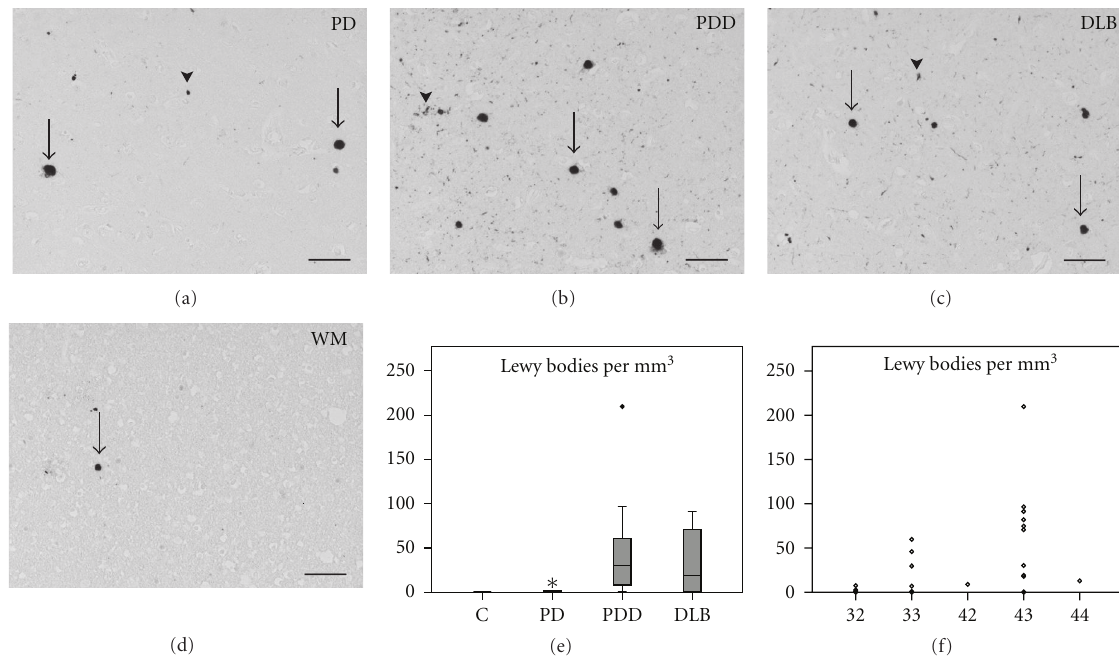
Figure 4: α -synuclein pathology in the human frontal cortex. (a–c) Lewy bodies (arrows) and Lewy neurites (arrowheads) in the grey matter of a Parkinson’s disease (PD; NBB 1999-038), Parkinson’s disease with dementia (PDD; NBB 2004-045), and dementia with Lewy bodies (DLB; NBB 1997-092) case. (d) a Lewy body (arrow) in the white matter (WM) of the frontal cortex of case NBB 2004-045. (e) Boxplot of the quantification of Lewy body number in the frontal cortex of 8 control, 6 PD, 11 PDD, and 9 DLB cases. (f) Lewy body numbers per ApoE genotype. Scale bars represent 100 μ